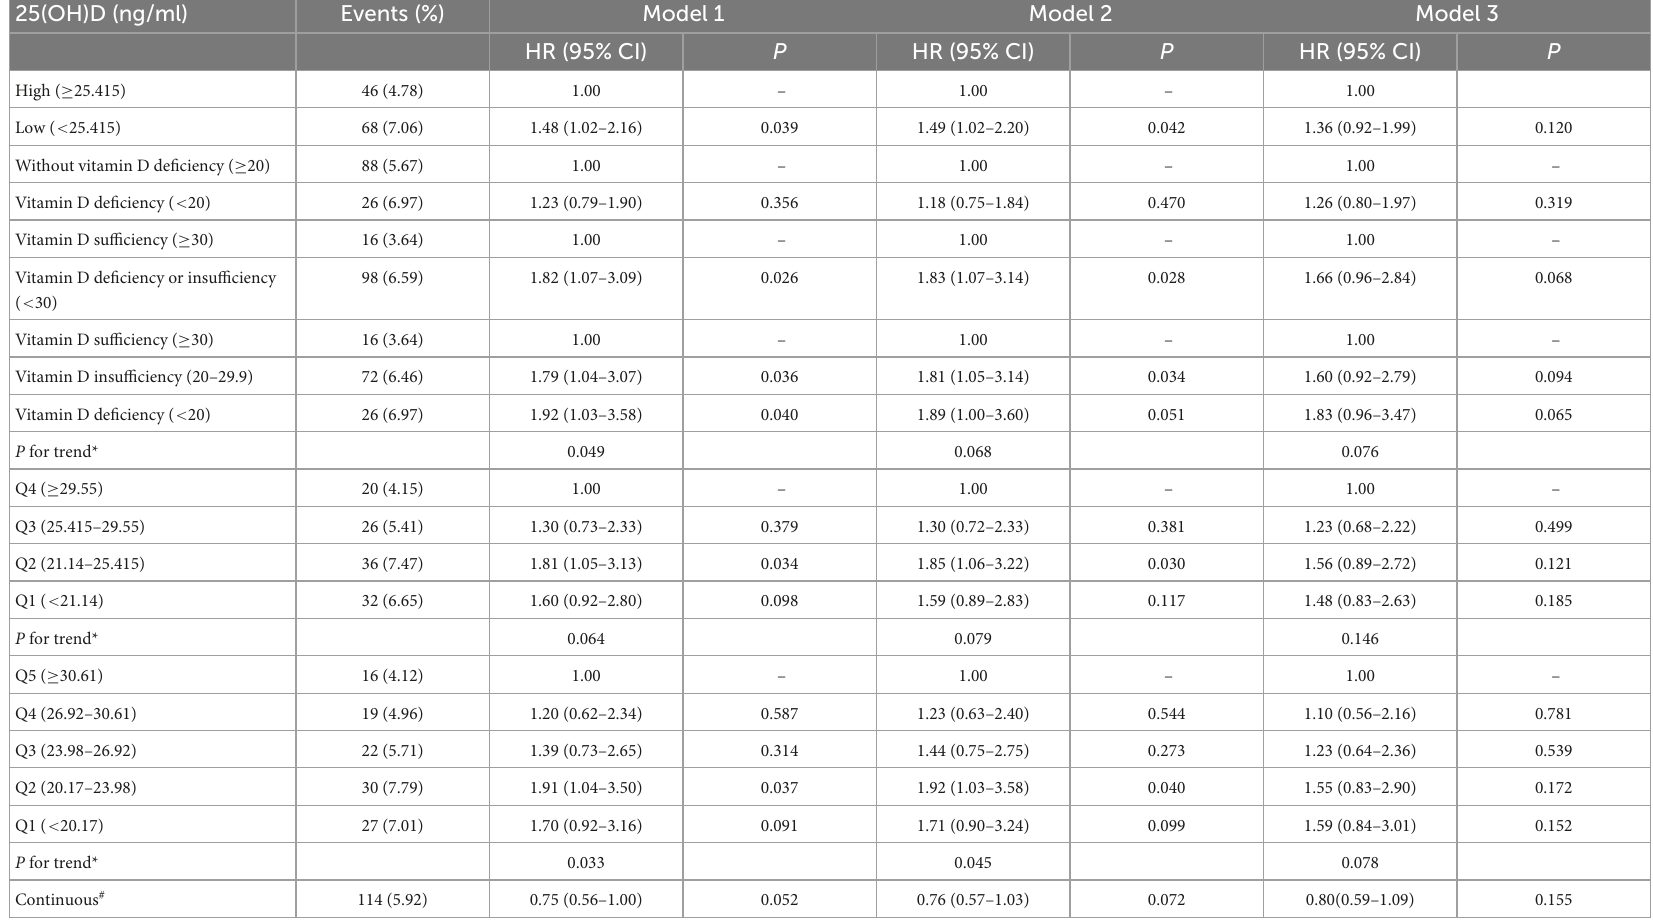
TABLE 2 Associations of serum 25(OH)D concentrations with incident type 2